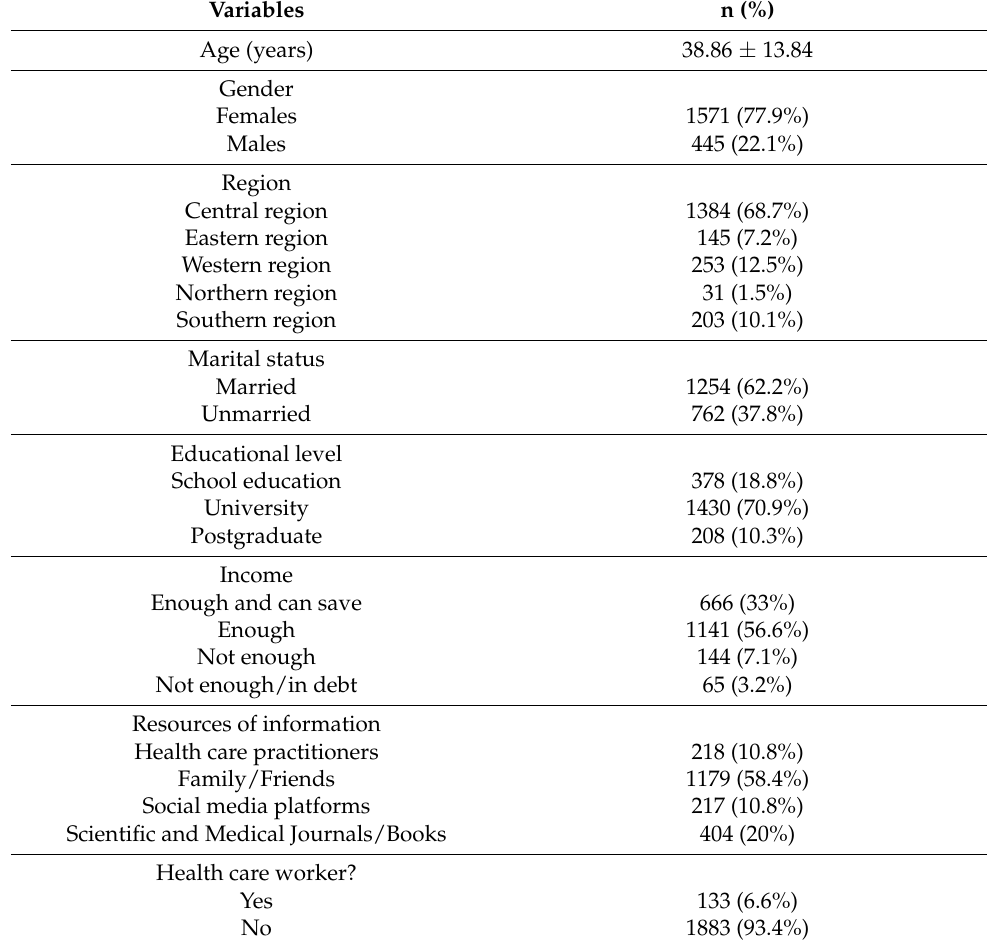
Table 1. Demographic characteristics of the study sample, n =